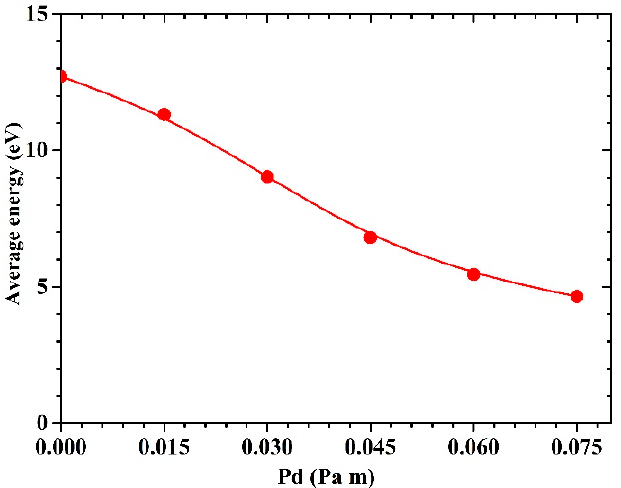
Figure 11. The average energy of sputtered atoms as a function of Pd values.